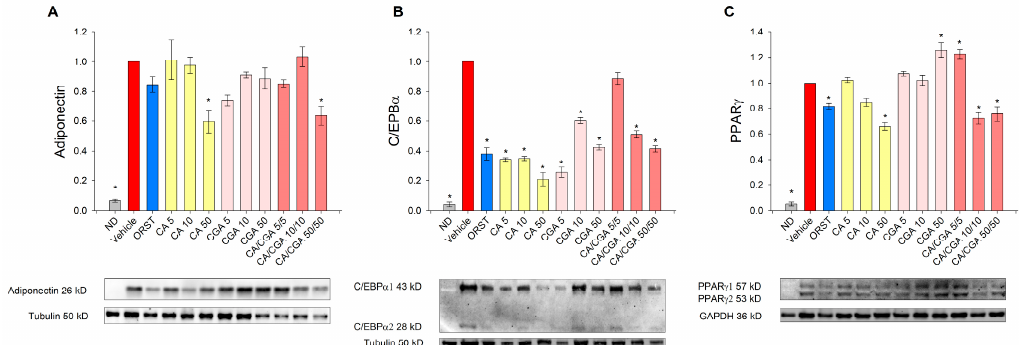
Figure 4. Caffeic and chlorogenic acids diminished adiponectin, CAAT/enhancer-binding protein alpha (C/EBP α ) and peroxisome proliferator-activated receptor γ (PPAR γ ) protein production in human SGBS adipocytes. Western blot analysis was performed to examine the protein level of adiponectin ( A ), C/EBP α ( B ) and PPAR γ ( C ). Data are expressed as mean ± SEM and are representative of three independent experiments. * p <0.05 compared to the vehicle control group.